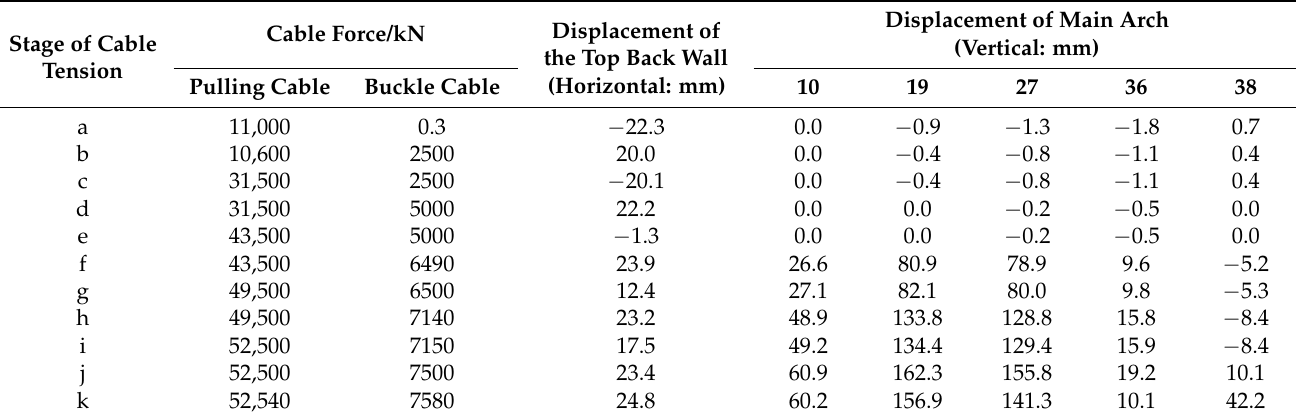
Table 1. Vertical displacement of the cable tension